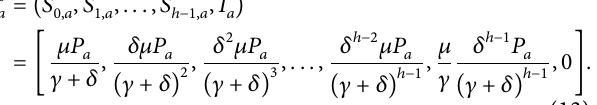
Figure 2: The time evolution of infection rates on a random network. (a) The solid and dotted lines represent numerical simulations and Monte Carlo simulations, respectively. Other parameters are set to be 𝛿 = 0.06, 𝛾 = 𝜇 = 0.1, ℎ = 3, 𝑁 = 5000, ⟨𝑘⟩ = 6, 𝐼(0) =